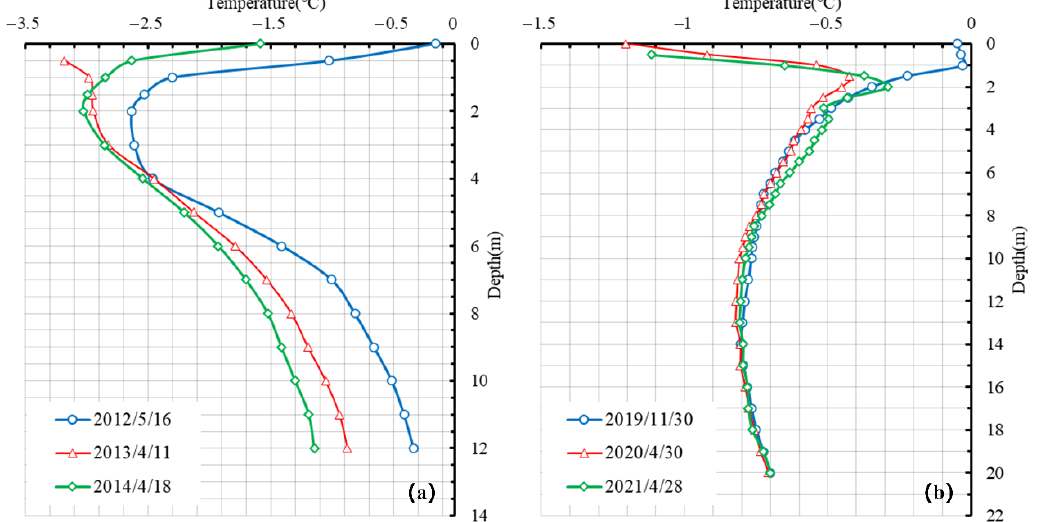
Figure 12. Ground temperature around ( a ) Zonag Lake (from Liu. et al. [35]) and ( b ) Salt Lake.